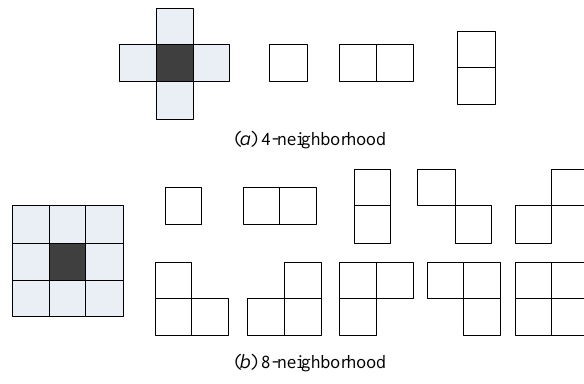
Fig. 1. Two types of neighborhood and their